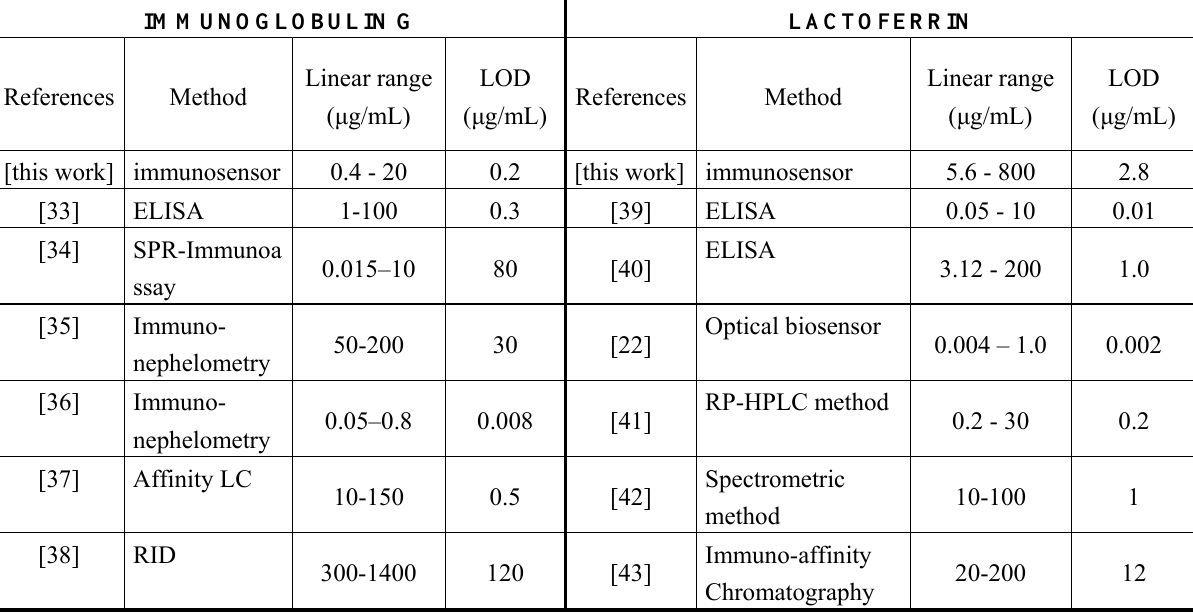
Table 5 . Comparison of analytical data found by several analytical methods for IgG or Lactoferrin analysis